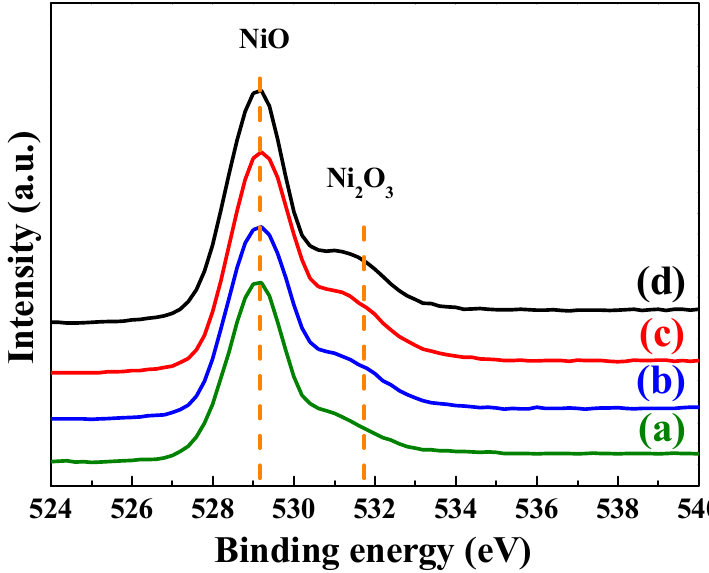
Figure 8. O 1s XPS spectra of the L2NiO thin films as a function of annealing temperatures and times.